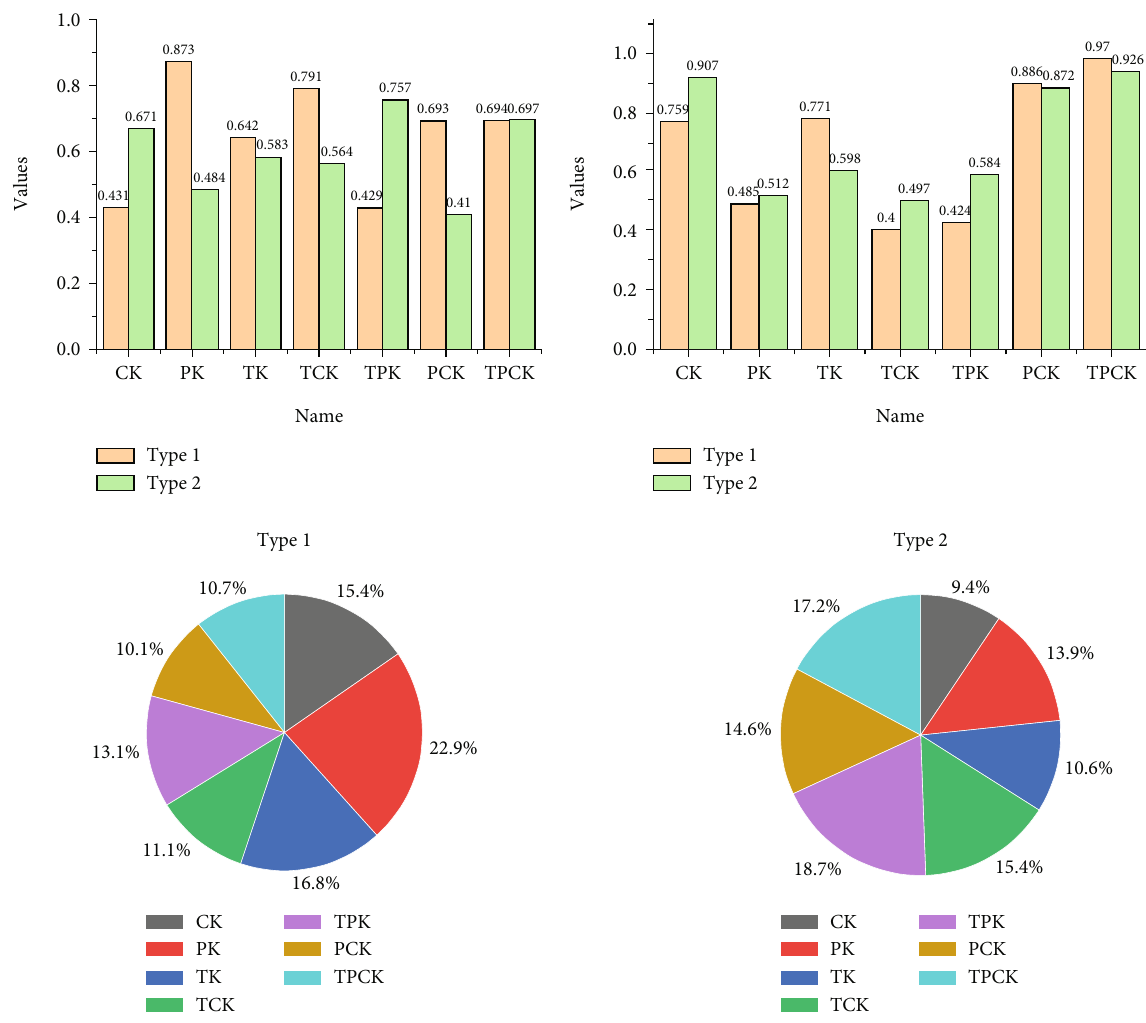
Figure 3: The proportion of time spent on each element of teacher A ’ s